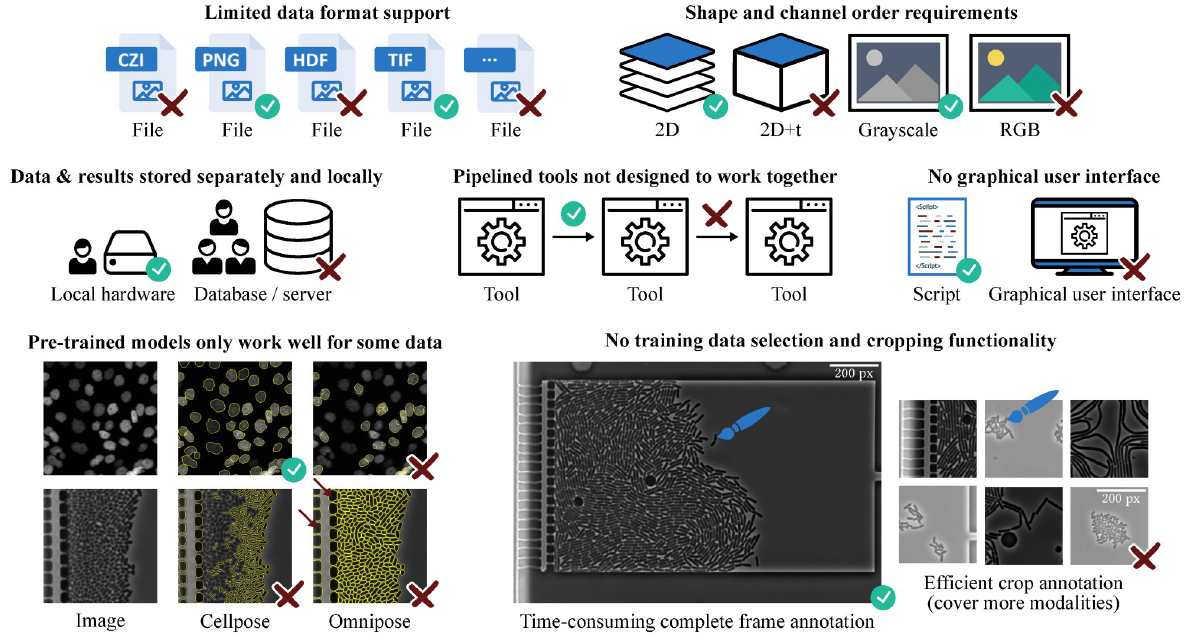
Fig 1. Typical barriers when using segmentation software. Cell segmentation methods are typically designed for specific applications and therefore often lack a data management system with a versatile data importer. This shortcoming results in the need for file format and image shape conversion steps. Furthermore, multiple tools often need to be combined to cover the whole workflow, from training data creation to applying trained models. Again, further processing steps may be required to enable tool compatibility. For many applications, it is not (yet) possible to do without own annotated training data. Interactive cropping functionalities are helpful in this case and enable an efficient annotation for dense-growing organisms. Nevertheless, this feature has not yet been included in cell segmentation software. Note: fluorescence images have been inverted for Omnipose [13], and phase contrast images have been inverted for Cellpose [14] for better